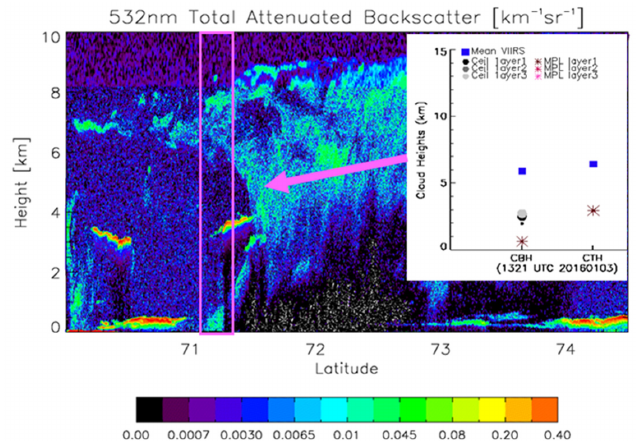
Figure 6. Comparison of S-NPP VIIRS CTH and CBH with CALIPSO lidar and ground ceilometer/lidar data for a multilayer cloud case near the ARM NSA site in Alaska as indicated in a pink rectangle (1321 UTC on 3 January 2016). Here, mean CTH and CBH from VIIRS (blue dots in the corner plot) only captured a topmost layer of the multilayered clouds, and ground ceilometer (black/gray circles) and lidar (brown/red asterisks) measurements reported lower-level layers.